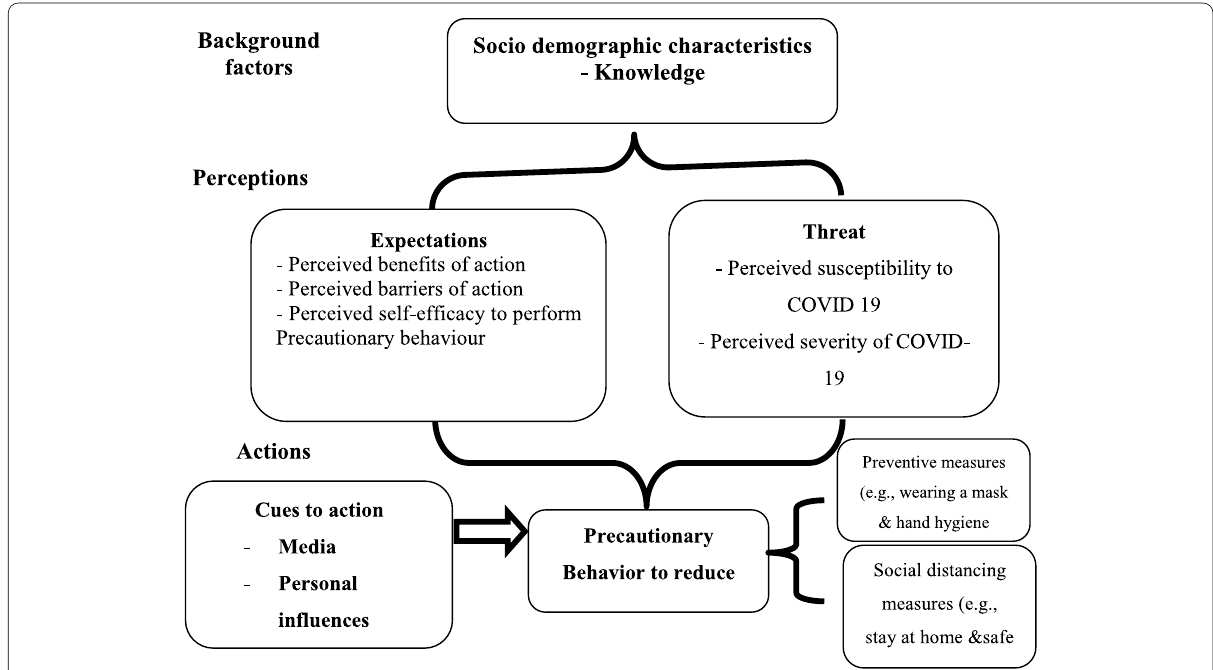
Fig. 1 Conceptual framework of adapted HBM and its main constructs [13,